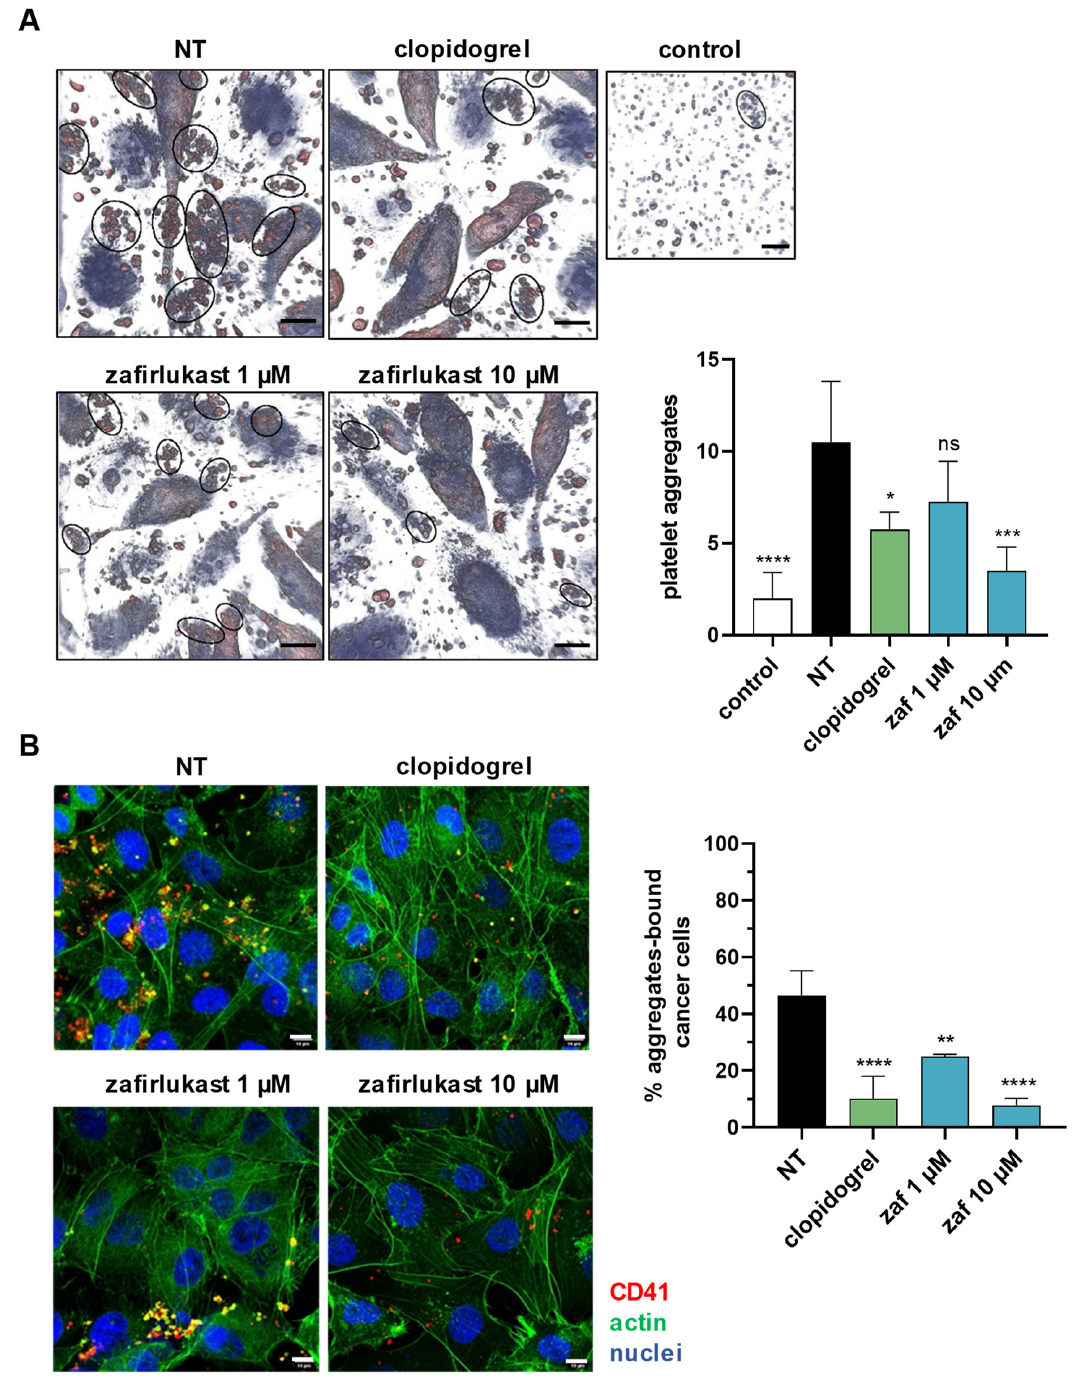
Figure 4. Cysteinyl leukotrienes mediate tumor-cell-induced platelet aggregation (TCIPA). ( A ) MDA-B02 breast cancer cells were cultured with human platelets and the different drugs for 48 h. Platelet aggregates (black circles) were imaged using a 3D Live Cell Explorer (Nanolive) and quantified. The data represents the mean ±SD of four images. Scale: 100 µm. ( B ) After 48 h of culture with MDA-B02 cells, non-adherent platelets were washed. Platelet aggregates bound to cancer cells were stained using an anti-CD41 antibody (red) and quantified using confocal microscopy. Actin from cells was stained using a A488-conjugated phalloidin probe (green) and nuclei were stained with DAPI (blue). The data represent the mean ± SD (n = 3), and the platelets come from two different donors. Scale: 10 µm (ns = not significant ; * p < 0.05; ** p < 0.005; *** p < 0.001; **** p < 0.00001 vs. NT; one-way ANOVA). Abbreviations: NT = non-treated; zaf = zafirlukast.